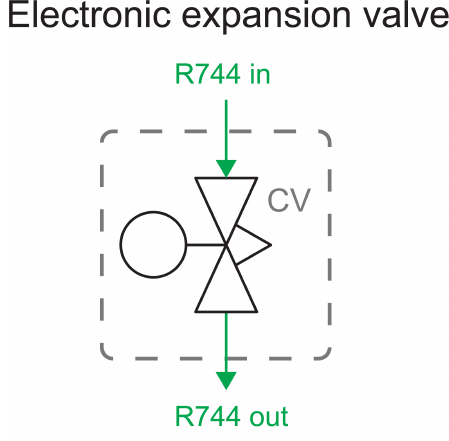
Figure A5. EV component with its CV